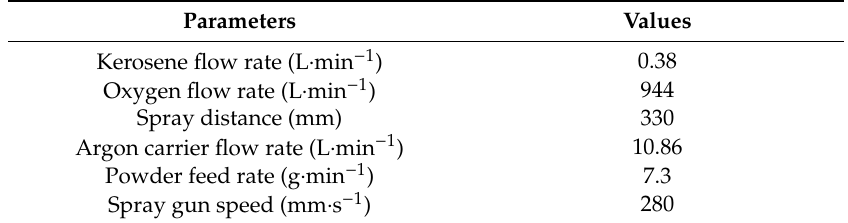
Table 1. Parameters and values of the high-velocity oxygen-fuel (HVOF) spraying